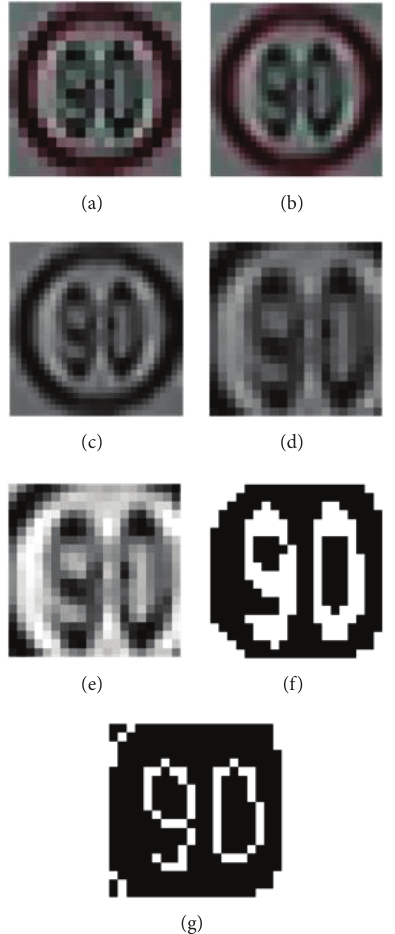
Figure 3: An example of ROI preprocessing in the proposed algorithm. (a) Input ROI, (b) normalized ROI, (c) gray image, (d) cropped image, (e) white balanced image, (f) binarized image, and (g) image after